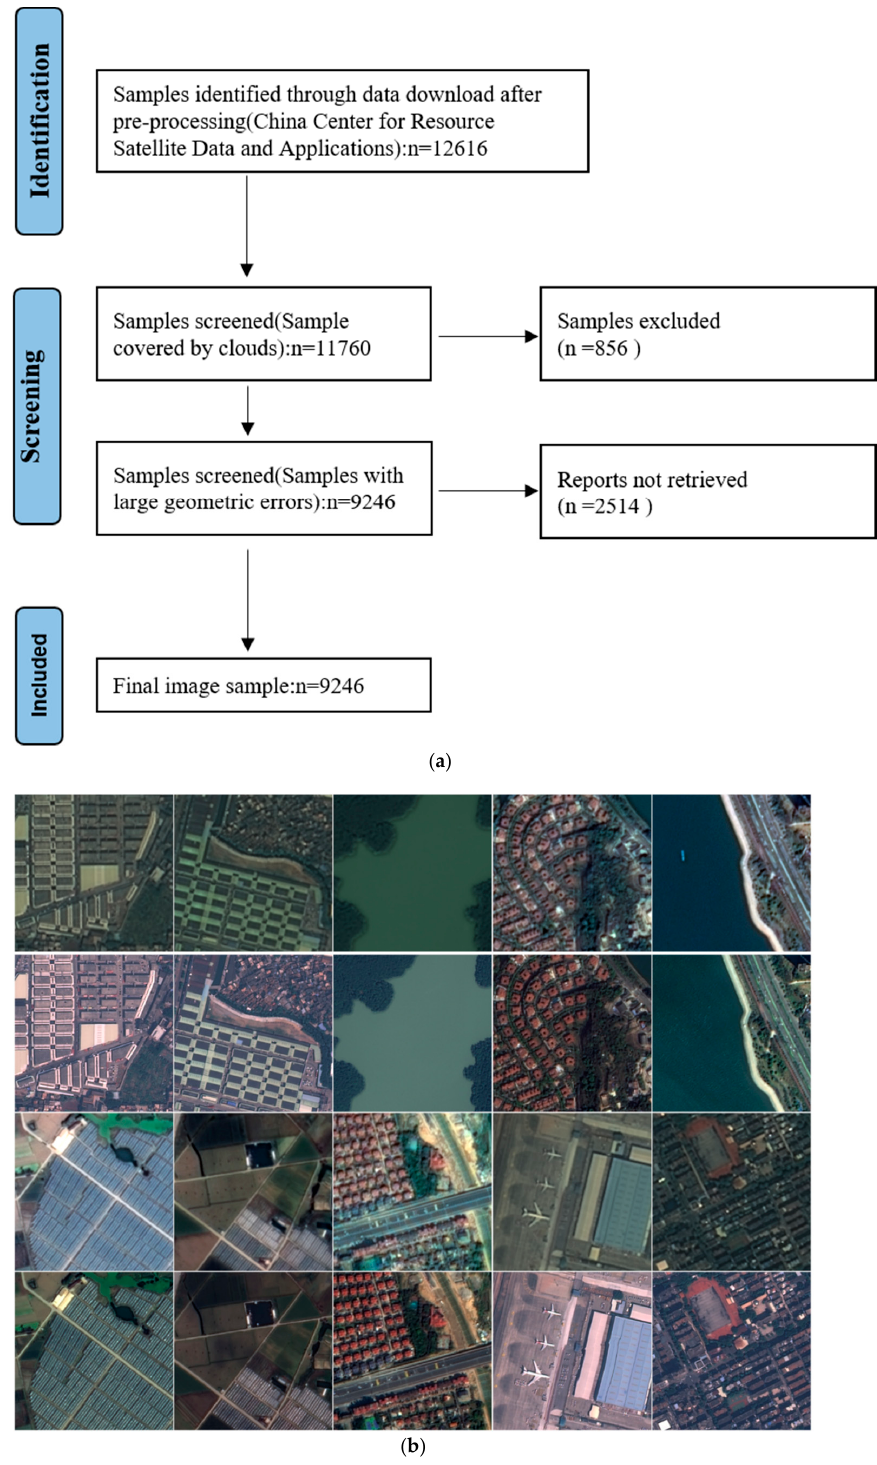
Figure 8. ( a ) The PRISMA diagram for sample identification . ( b ) The proposed dataset, where the odd rows are the LR images and the even rows are the HR images.